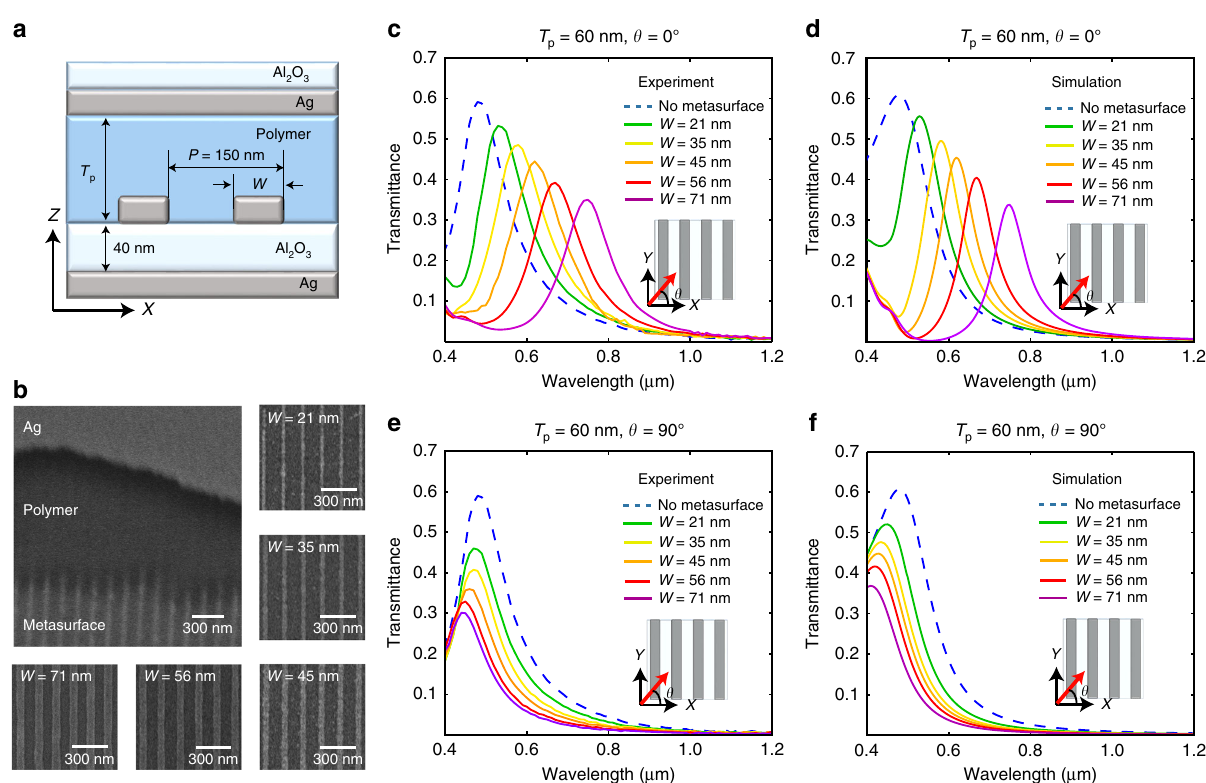
Fig. 2 Spectral transmission of Ag based nanocavities with and without the metasurface. a Cross-sectional schematic of the metasurface-based nanocavity. P and W are the perodicity and linewidth of Ag grating, respectively. T p is the thickness of polymer layer. The thickness of both top and bottom Ag mirror is 15 nm and the thickness of grating is 22 nm. b 30° tilted view and Top view of FE SEM (Field Emission Scanning Electron Microscopy) image of fabricated nanocavity. Experiment ( c , e ) and simulation ( d , f ) of transmission spectra of nanocavity with 60 nm thick polymer spacer (inset in c : the schematic of polarization direction, θ is the angle of polarization of incident wave): c , d θ = 0° and e , f θ =